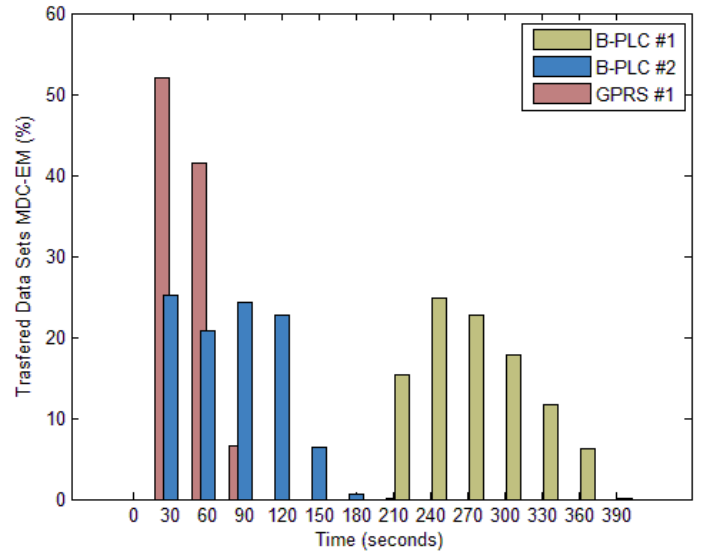
Figure 6. Time distribution of the data availability at the MDC tier during the acquisition of load profile data given for different TSC areas.